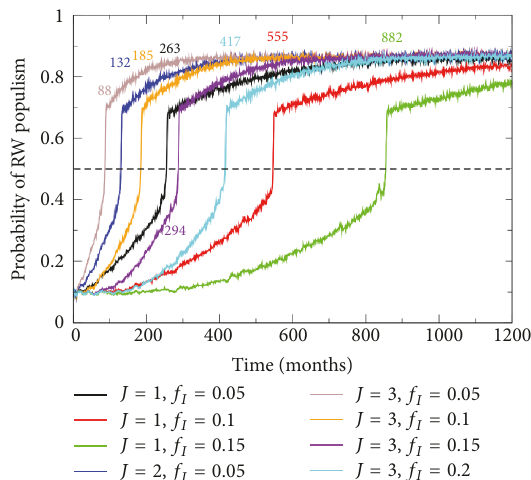
Figure 6: Predicting the timing of RW populism . We find that for a broad range of outsider inflows ( 𝐽 ) and tolerance parameter values ( 𝑓 󸀠 𝐼 ), (5) predicts the moment at which 𝑃 > 0.5 in a manner that agrees favorably with the simulation results. Except for 𝛾 = 0 , other parameters are the same as in Figure